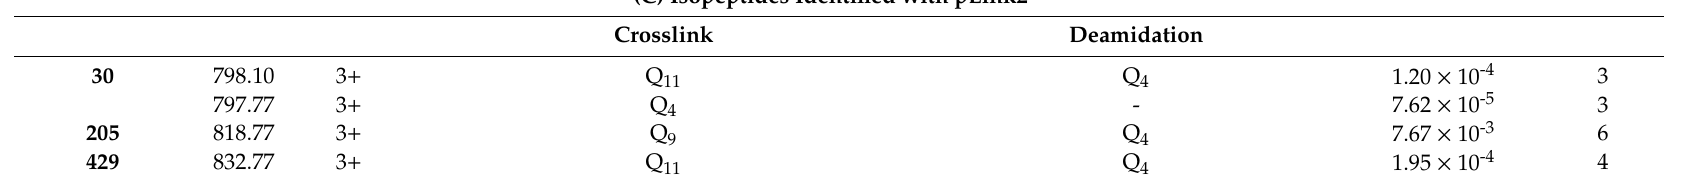
(C) Isopeptides Identified with pLink2 d